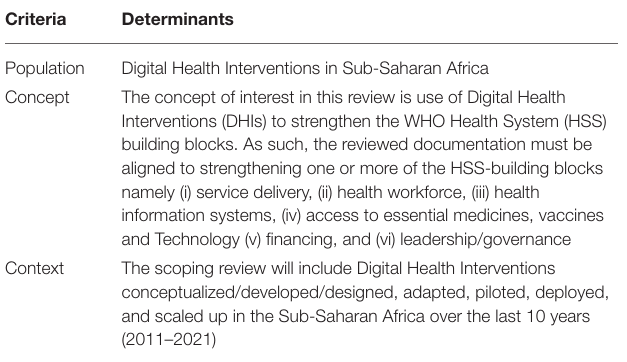
TABLE 1 | PCC study for eligibility of scoping review studies. TABLE 2 | Scoping review eligibility criteria.